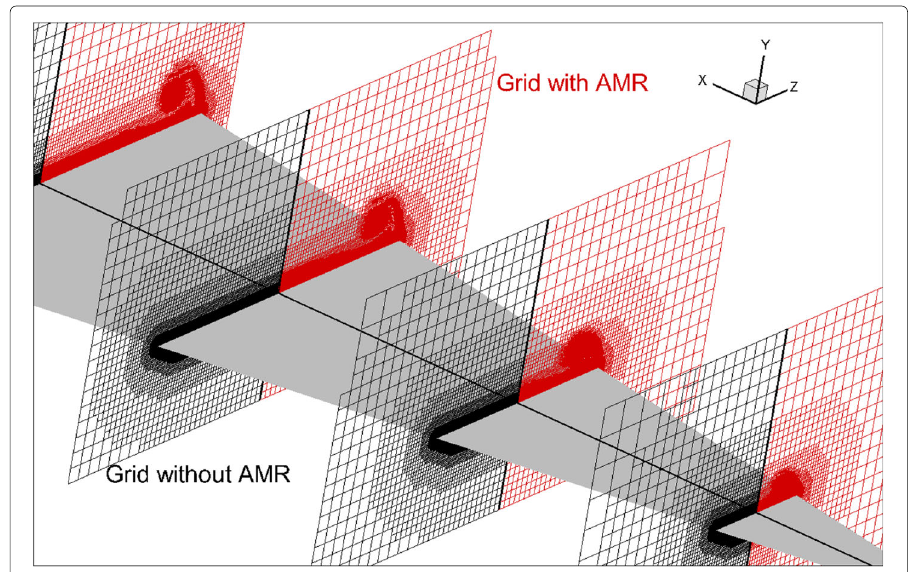
Fig. 29 Comparison of the grid with and without AMR